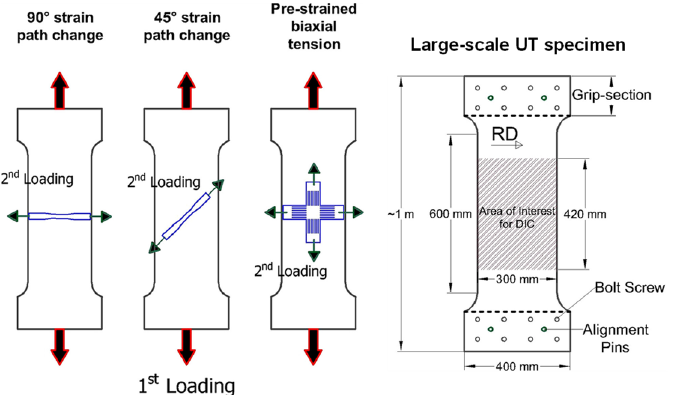
Figure 20. Schematic illustration of the selection of standard specimens from the uniform region of the large-scale specimen. Reprinted from Ref. [302] with permission. Copyright 2018, Elsevier.